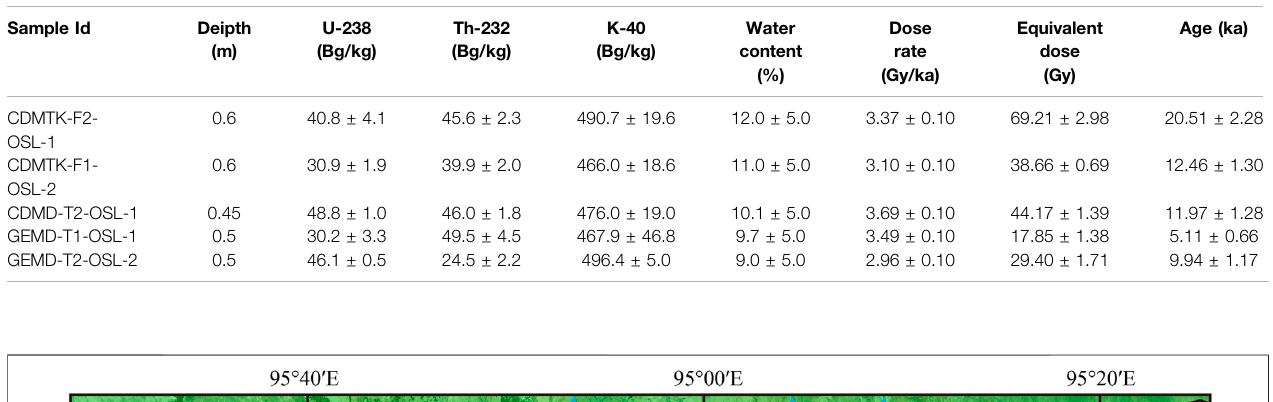
TABLE 1 | OSL samples and dating results.